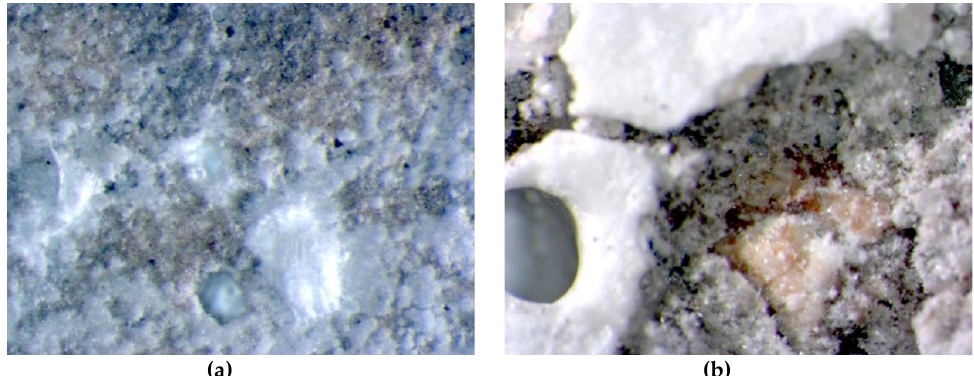
Figure 7. Microscopic images of cement mortar without polymer stored in 5% MgSO 4 solution: ( a ) after 12 months; ( b ) after 42 months; magn. 50×.